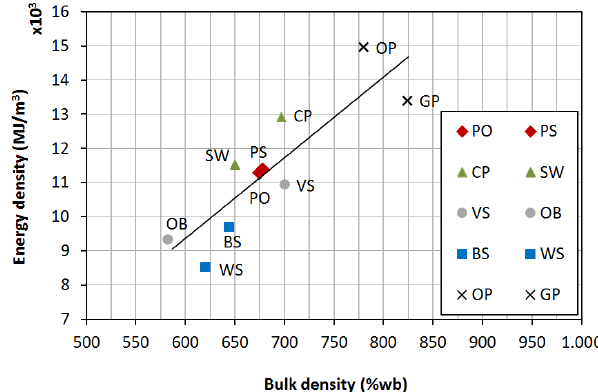
Figure 4. Relationship between bulk density and energy